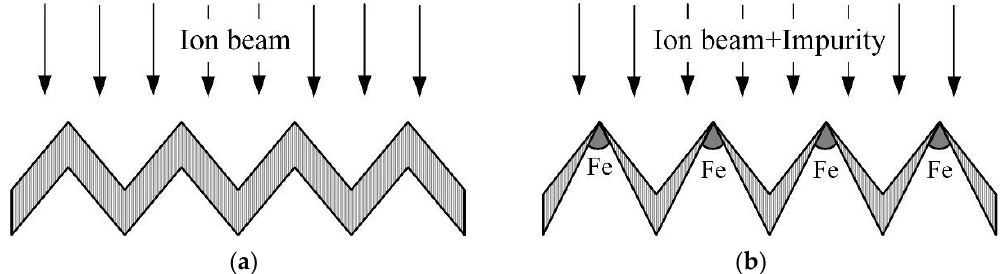
Figure 3. Schematic diagram of preferential sputtering theory. ( a ) Schematic diagram of pure ion beam sputtering; ( b ) Schematic diagram of impurity co-deposition ion beam sputtering.